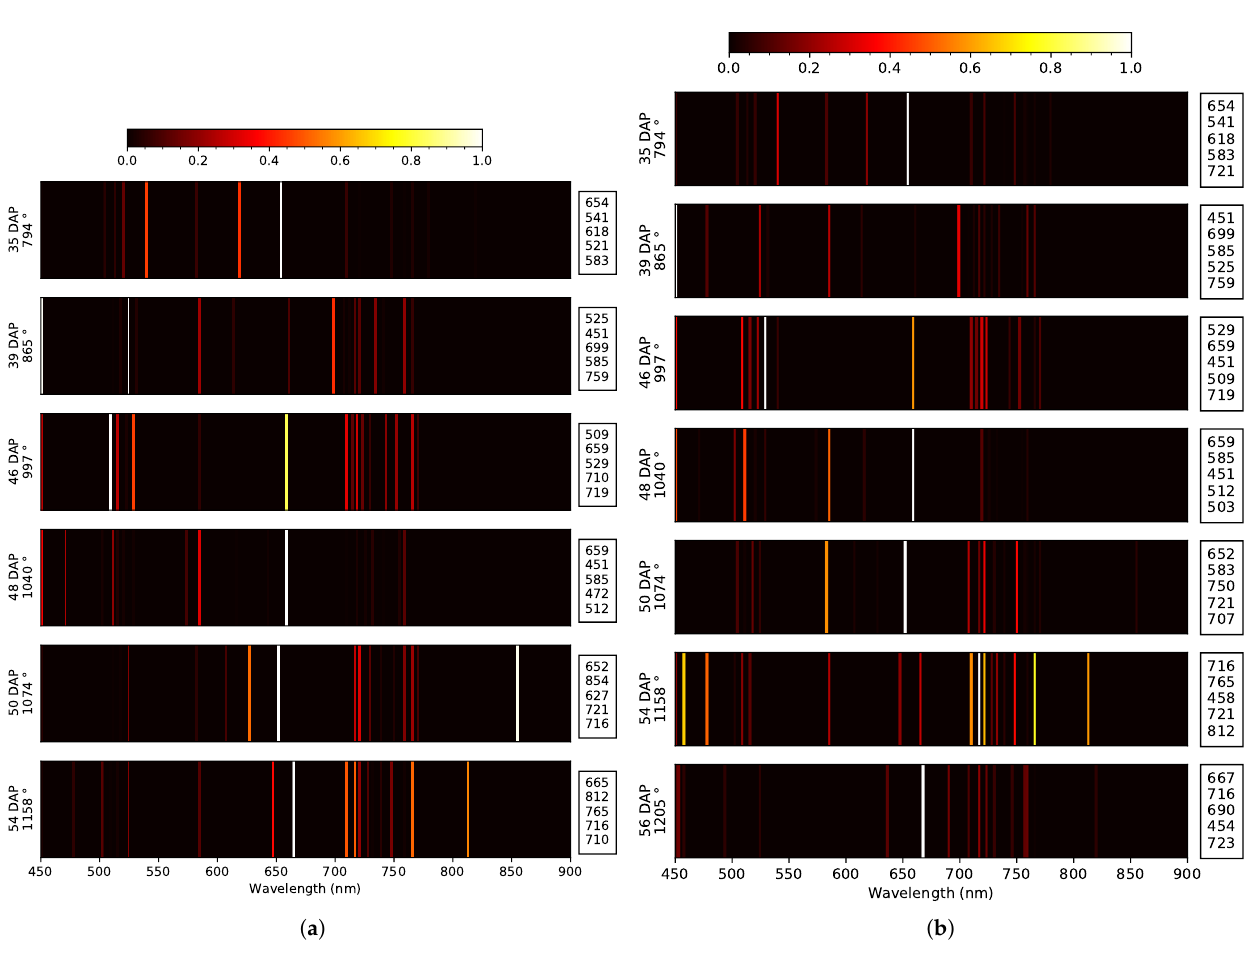
Figure 17. Snap bean seed length 2019 average rankings across all four optimization models for SAM model at ( a ) the early harvest stage and ( b ) the late harvest stage. The corresponding days after planting (DAP) and heat unit for the collected data are shown to the left of each ranking belt, while the top five features, with the first one having the highest score, are listed to the